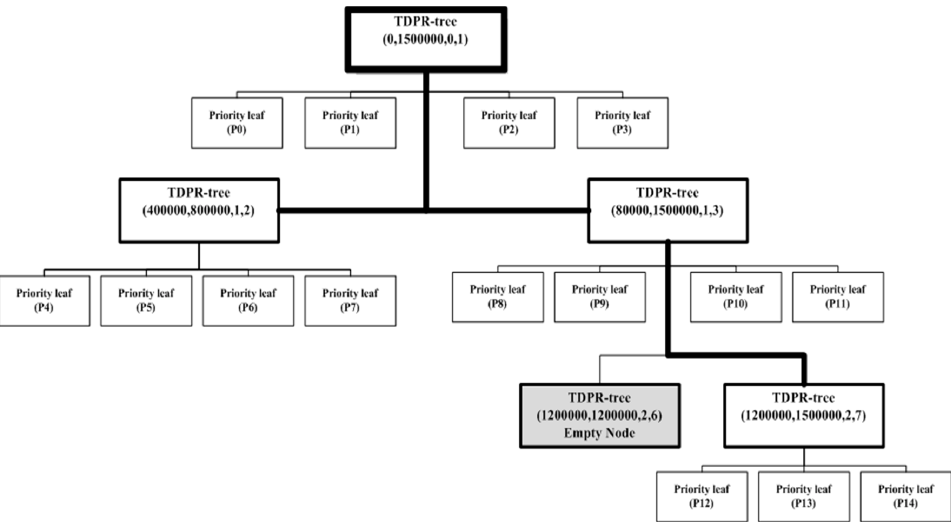
Figure 3. 2DPR-Tree structure for a file with a 1.5 M rectangle.